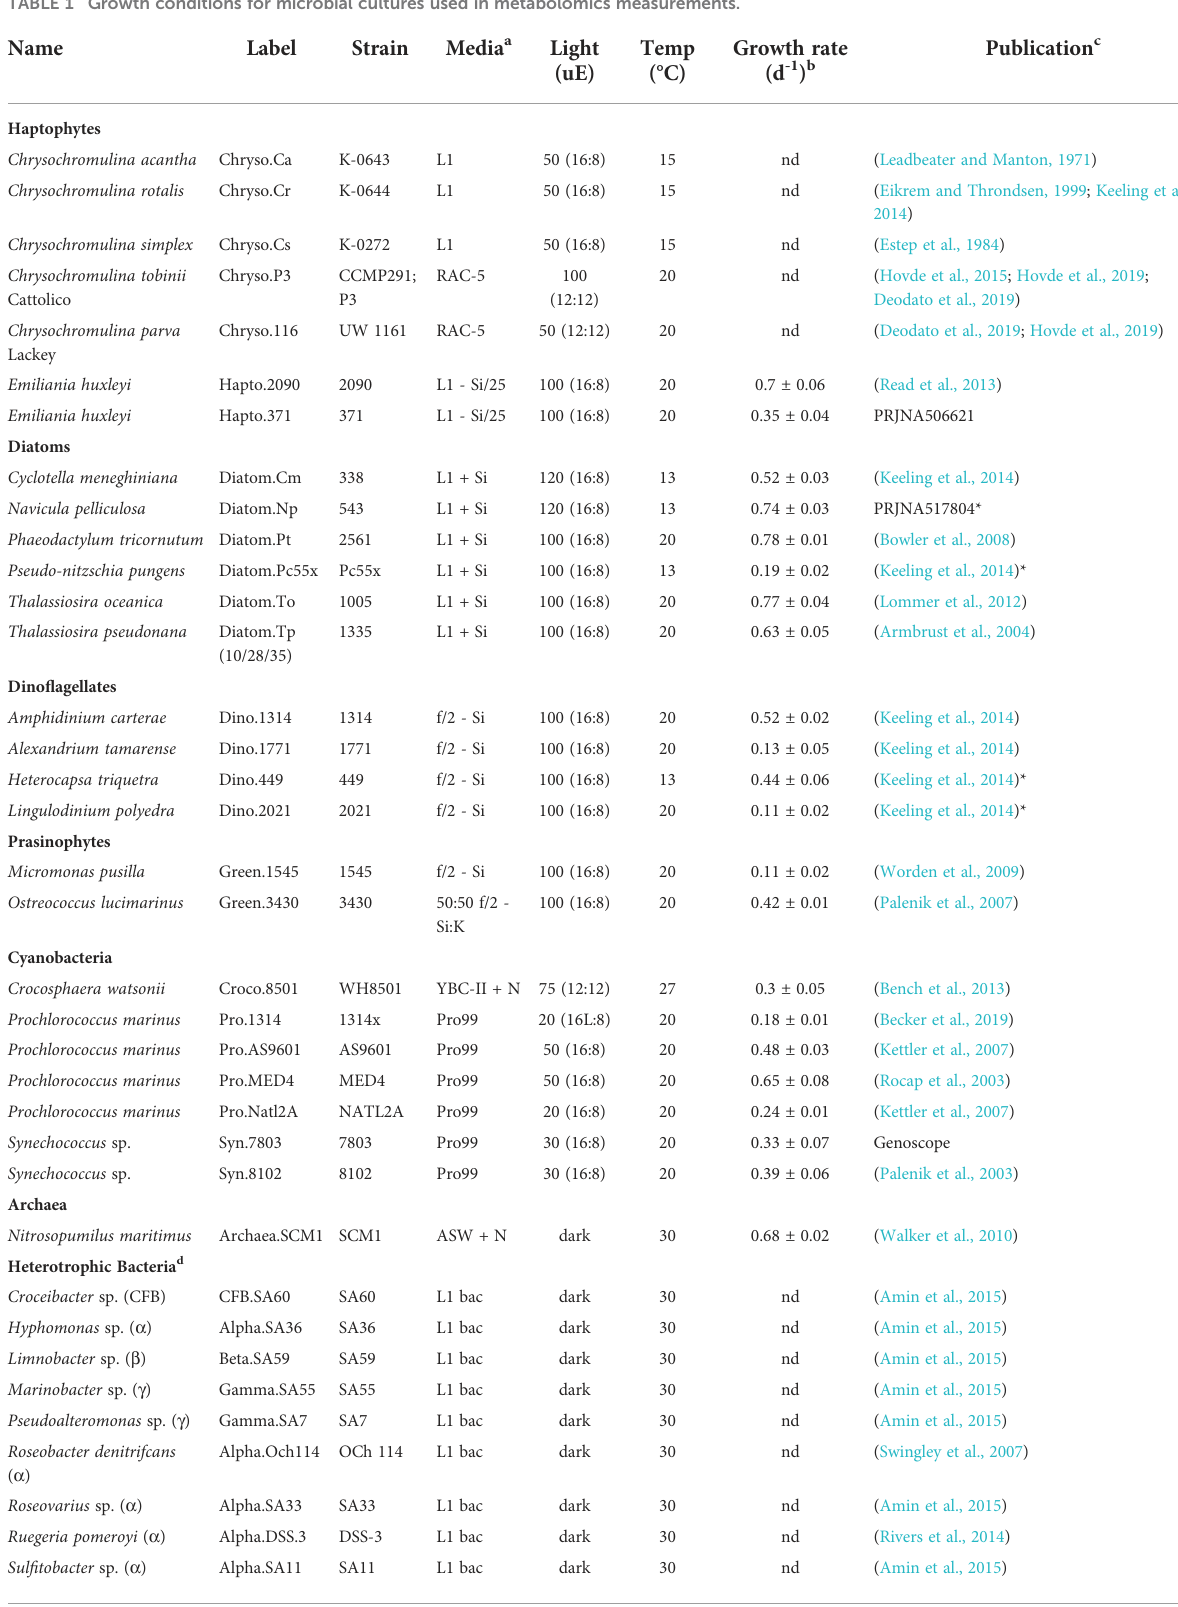
TABLE 1 Growth conditions for microbial cultures used in metabolomics